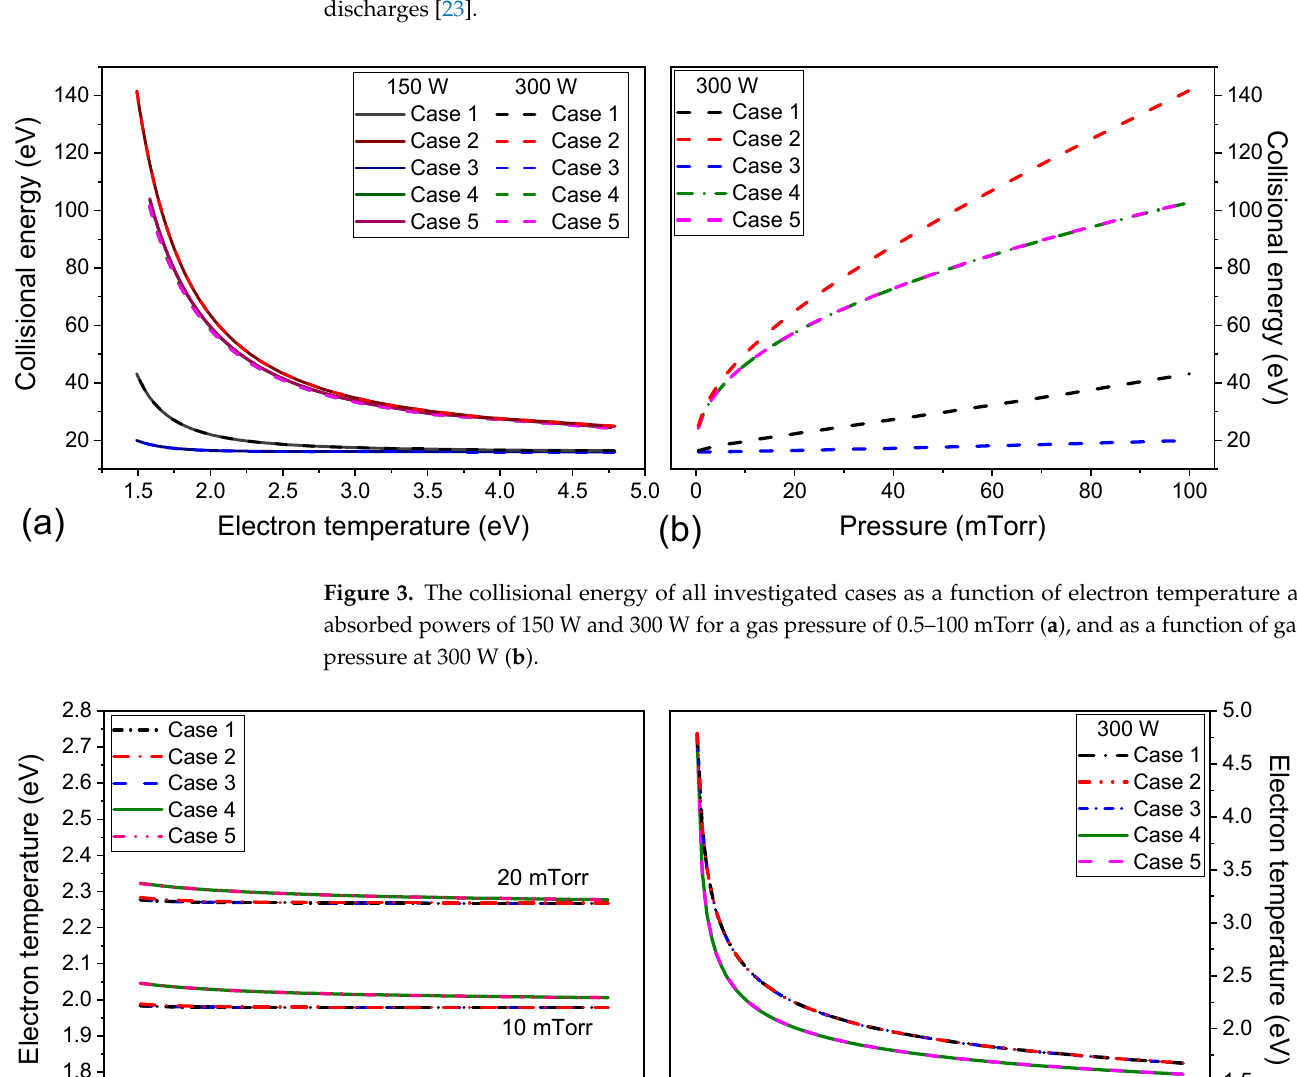
experimental observations evidence a non-Maxwellian energy distribution function for argon ICP discharges [23].